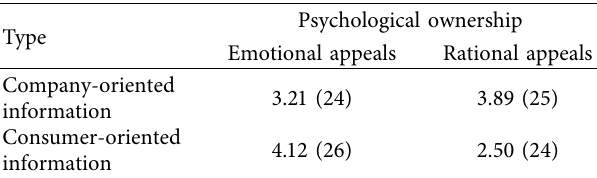
Table 4: Moderating of advertising information expression (re- search